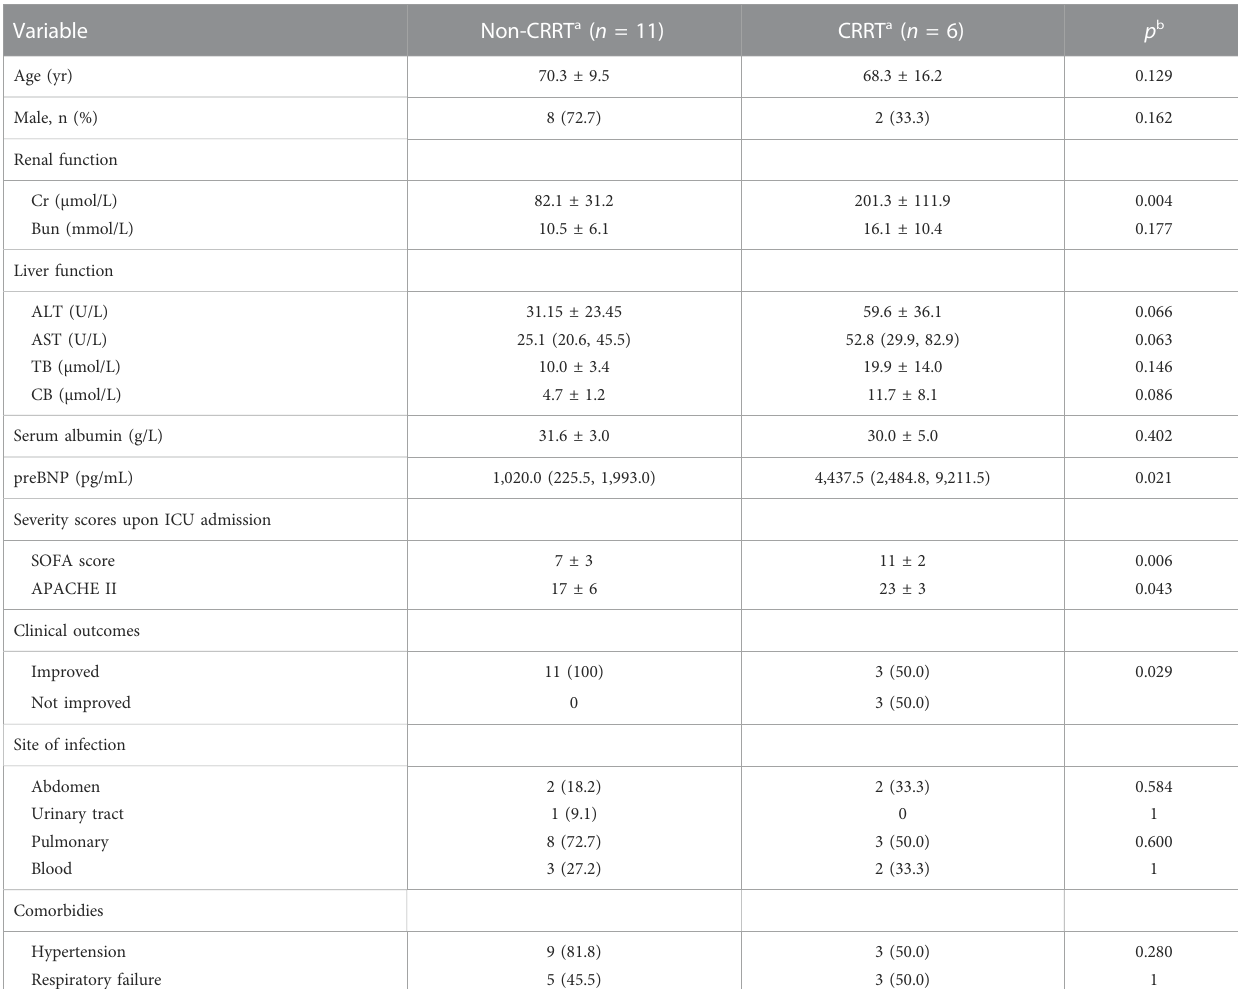
TABLE 1 Characteristics of enrolled